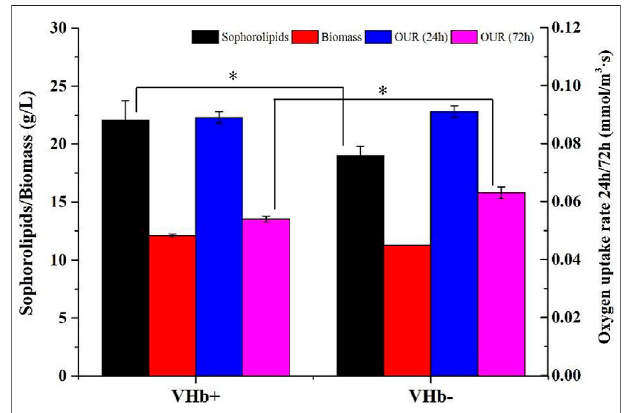
FIGURE3| ComparisonofsophorolipidfermentationbetweentheVHb + and VHb − strains cultivated in shake fl asks (* p < 0.05).